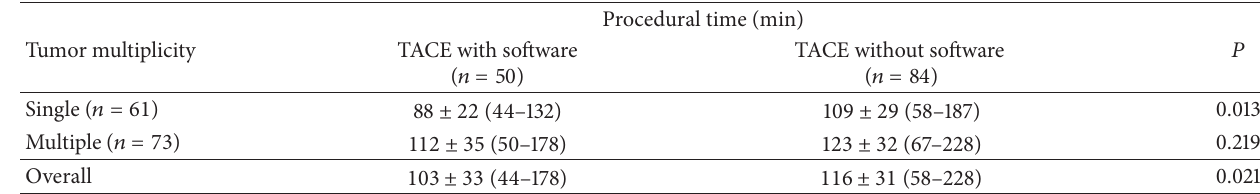
Table 3: Procedural time required for a single chemoembolization. Tumor multiplicity